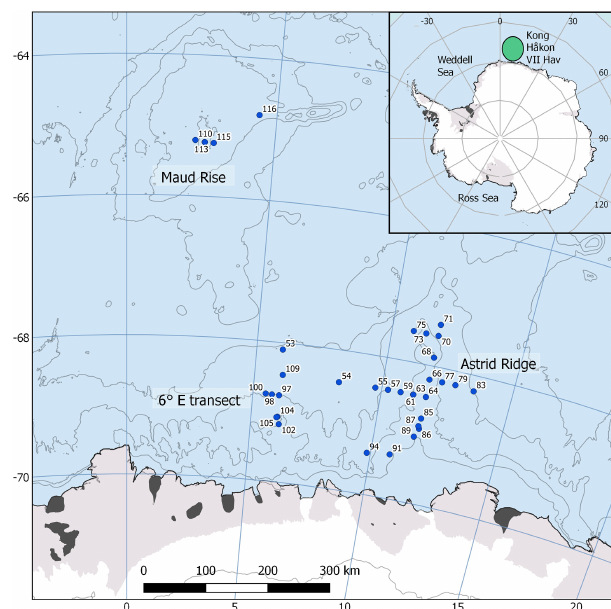
Figure 1. Map of the study area. The CTD stations with water sam- pling are marked with blue circles. The sampling area is marked with a green ellipse in the inset. The contour interval is 1000m. Map created with the help of Quantarctica (Norwegian Polar Insti- tute,